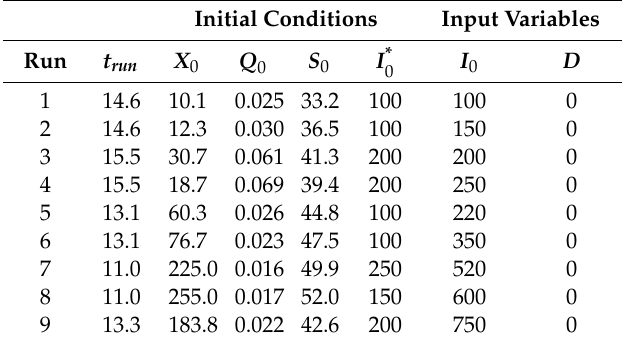
Table 2. Initial conditions, input variables values, and cultivation time for each culture run. (Physical units are defined in Table A1).